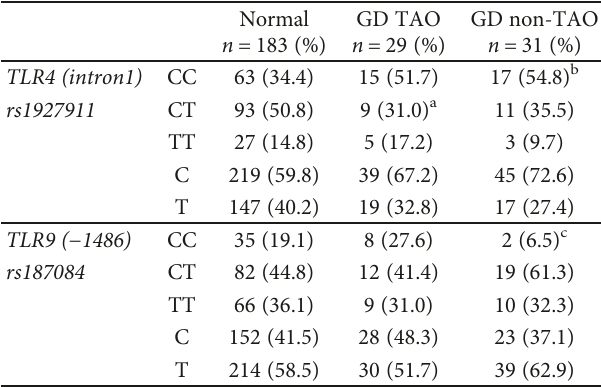
AITD: autoimmune thyroid diseases; GD: Graves ’ disease; TAO: thyroid- associated ophthalmopathy. Controls versus TAO: a OR= 0.4 (0.18 – 1.00), P = 0 047 ; controls versus non-TAO: b OR= 2.31 (1.07 – 4.99), P = 0 029 ; TAO versus non-TAO: c OR= 5.52 (1.06 – 28.7), P = 0 028 .